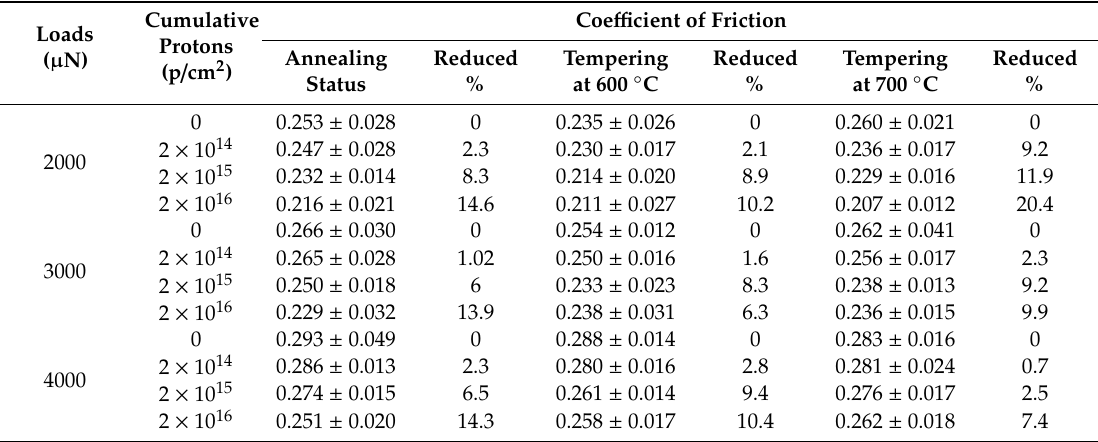
Table 4. Average nano-friction coe ffi cients of AISI 420 stainless steels after proton radiation with di ff erent cumulative